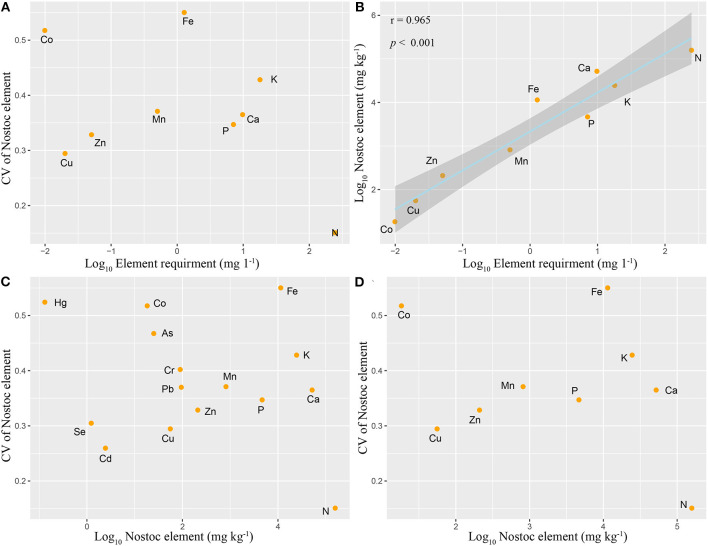
Relationships between N. commune elemental requirement, mean N. commune elemental concentration, and its coefficient of variation (CV). (A) CV vs. Elemental requirement; (B) Nostoc element (heavy metals not included) vs. Elemental requirement, Log10(y) = 0.893 Log10(x) +3.333 (r2 = 0.965, p < 0.001); (C) CV vs. Nostoc element (heavy metals included); (D) CV vs. Nostoc element (heavy metals not included). Ninety fine percentage of confidence bands for all fitted curves are also shown.